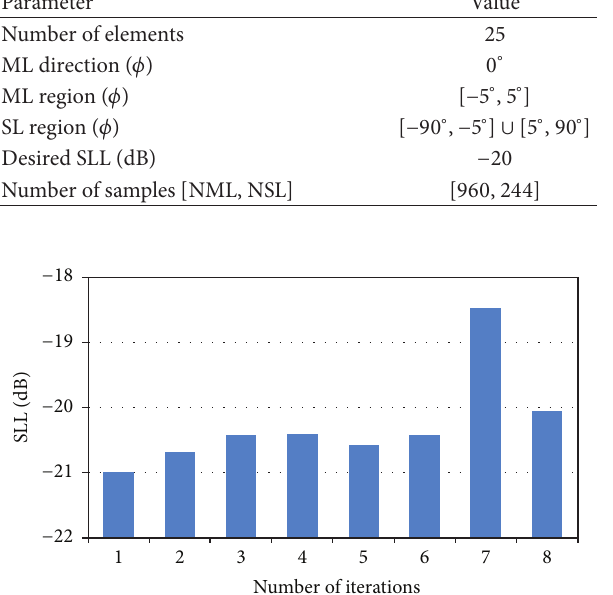
Figure 2: Number of iterations in relation to SLL with the target SLL of ≤− 20 dB.